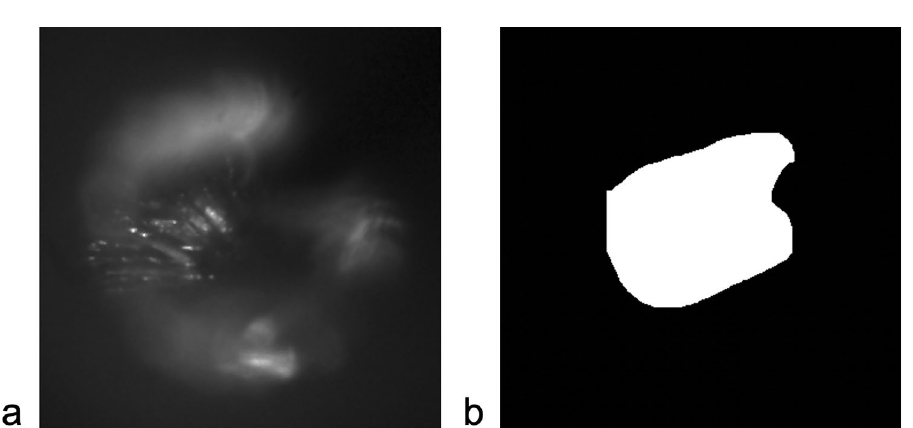
Figure 3. Sample image undergoing semantic segmentation. ( a ) Example of an input taken from a single SWIR frame, ( b ) output image as a binary mask after segmentation. The white portion indicates the region of interest.